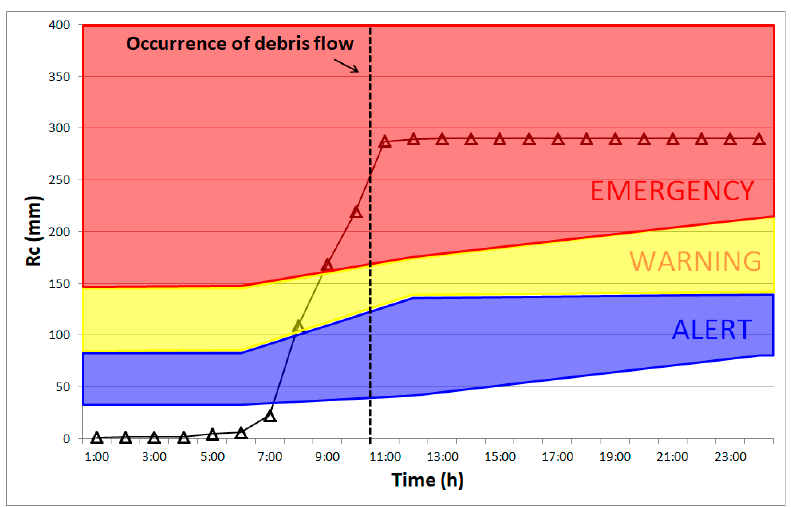
Figure 20. Debris flow forecasting using nomogram (Case 3).